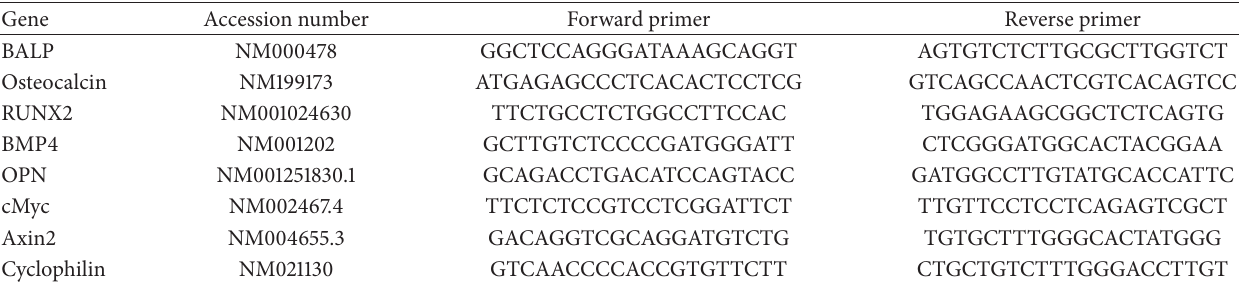
Table 2: Primers used in the experimental